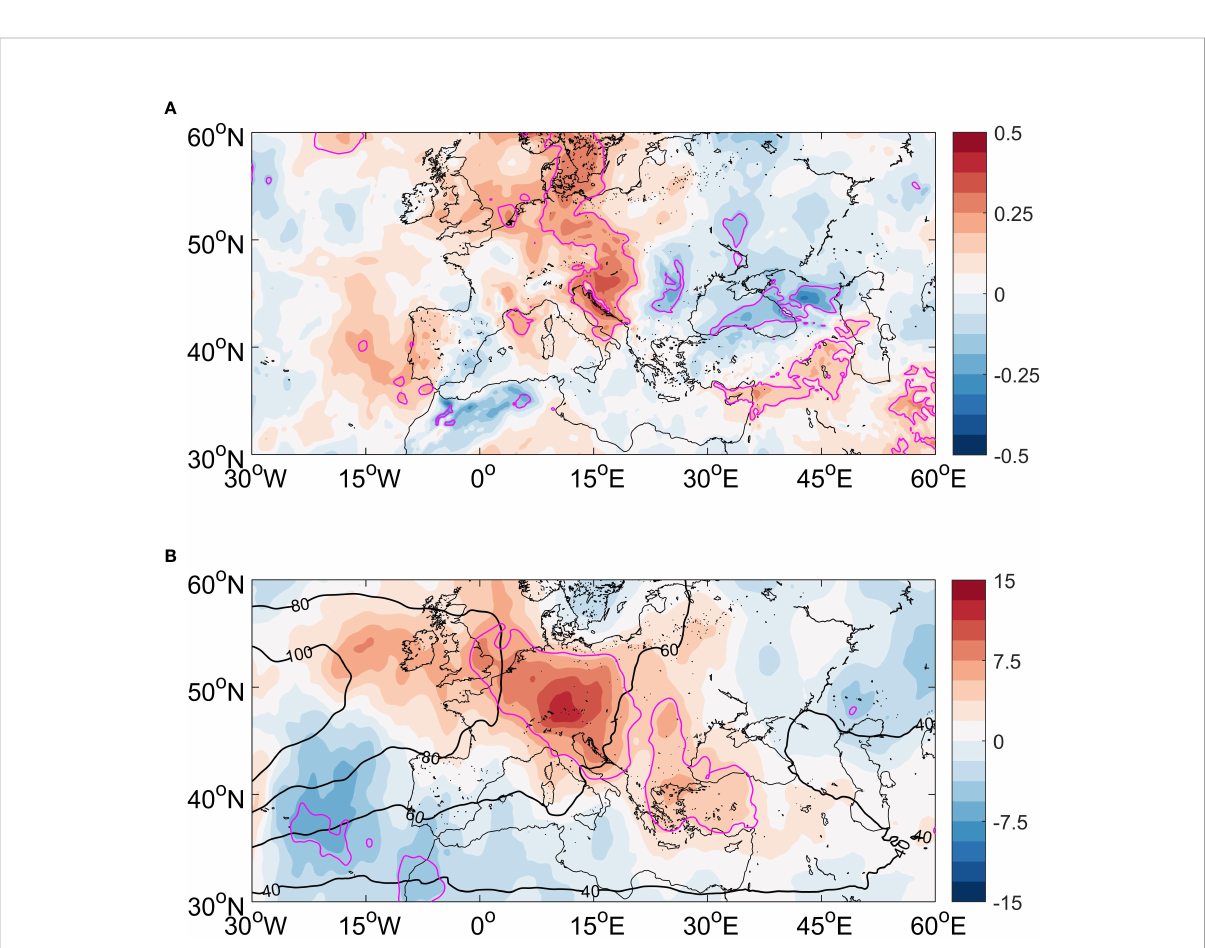
FIGURE 9 The lagged regressions of (A) EGR (shading; unit, 10 − 6 s − 1 ) and (B) storm track (shading; unit, m 2 s − 2 ) at the 300-hPa level in DJF onto the KEI 2 months earlier, with magenta contours representing the regions where atmospheric anomalies pass the 90% con fi dence level. The black contours in panel (B) show the 300-hPa winter background storm track (contours at 20-m 2 s − 2 intervals). EGR, Eady growth rate; KEI, Kuroshio Extension